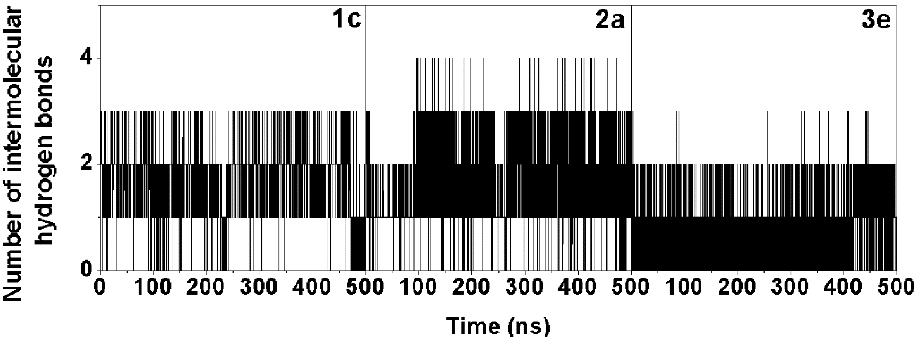
Figure 5. Time evolution of the number of intermolecular hydrogen bonds (H-bonds) formed between the EGFR-TK residues and the three screened